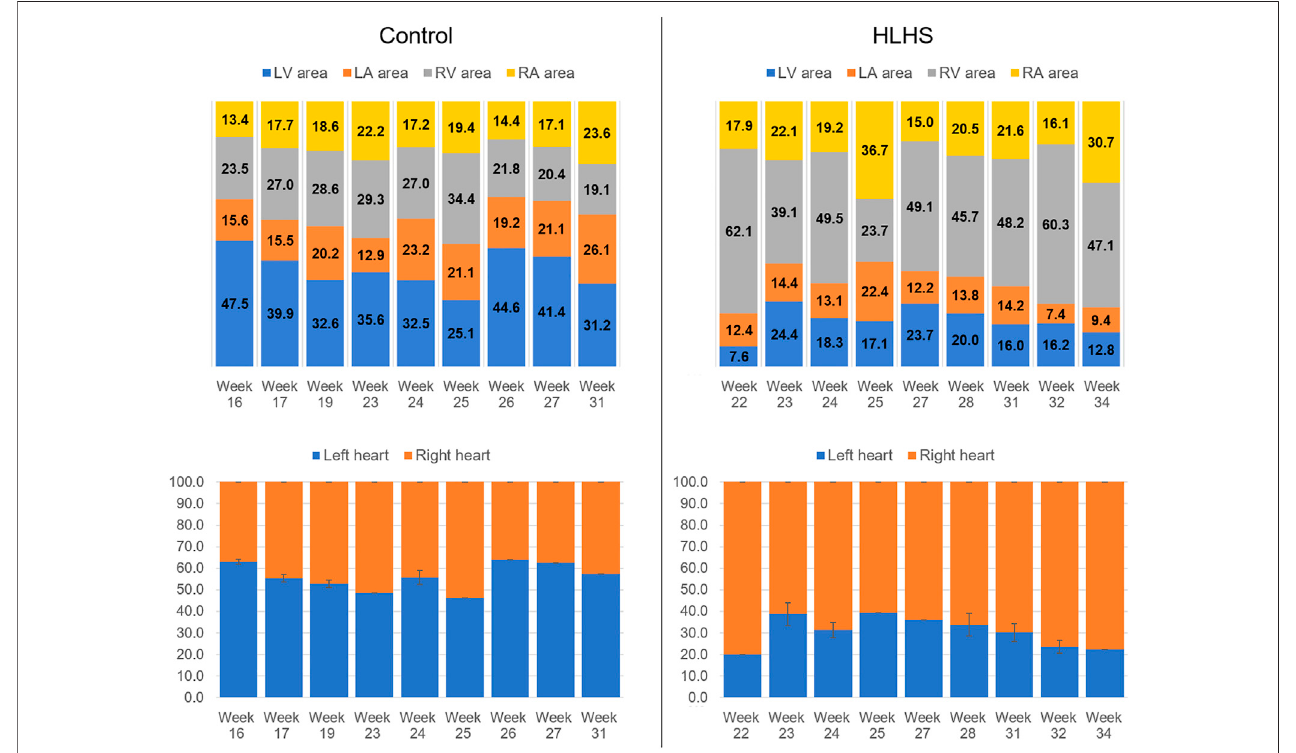
FIGURE 3 | Percent chamber areas and the area ratios between the left and right sides of the control and HLHS hearts.